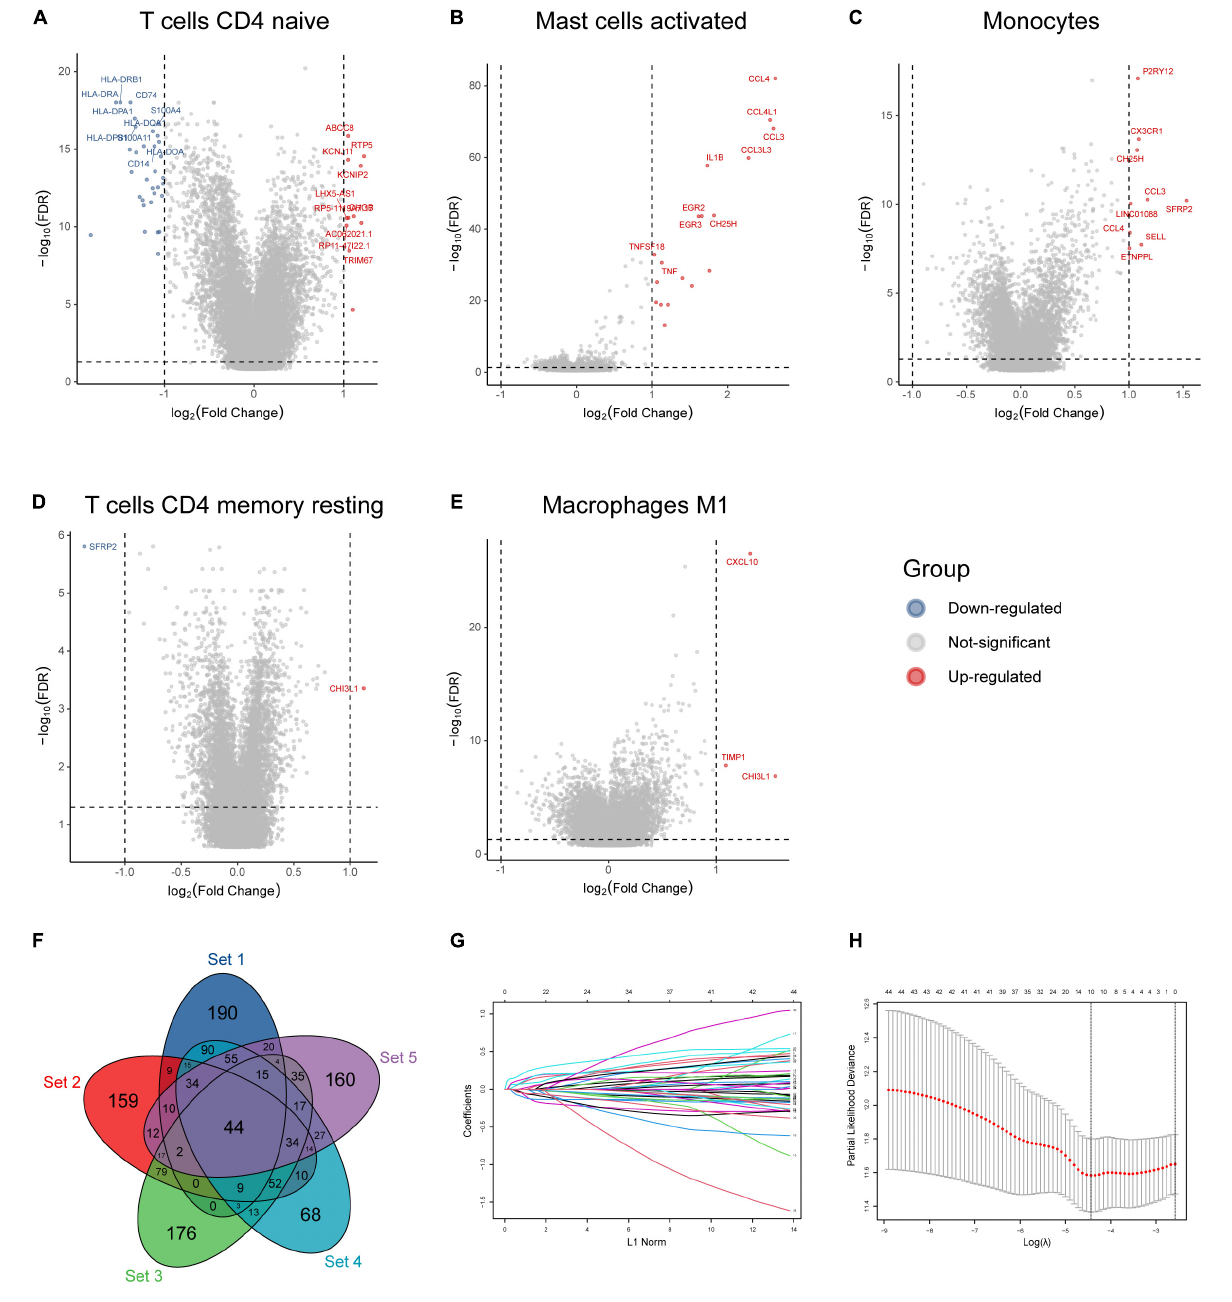
FIGURE 2 | Identification of immune infiltration-related hub genes and LASSO analysis. (A–E) Volcano plot of DEGs based on the mean abundances of survival-related infiltrates in glioma. (F) Forty-four hub genes identified by overlapping the five gene sets. (G) LASSO coefficient profiles of the 44 hub genes. Each curve represents a coefficient, and the x -axis represents the regularization penalty parameter. As λ changes, a coefficient that becomes non-zero enters the LASSO regression model. (H) Cross-validation to select the optimal tuning parameter ( λ ). The left dotted vertical line crosses over the optimal log λ , which corresponds to the minimum value for multivariate Cox